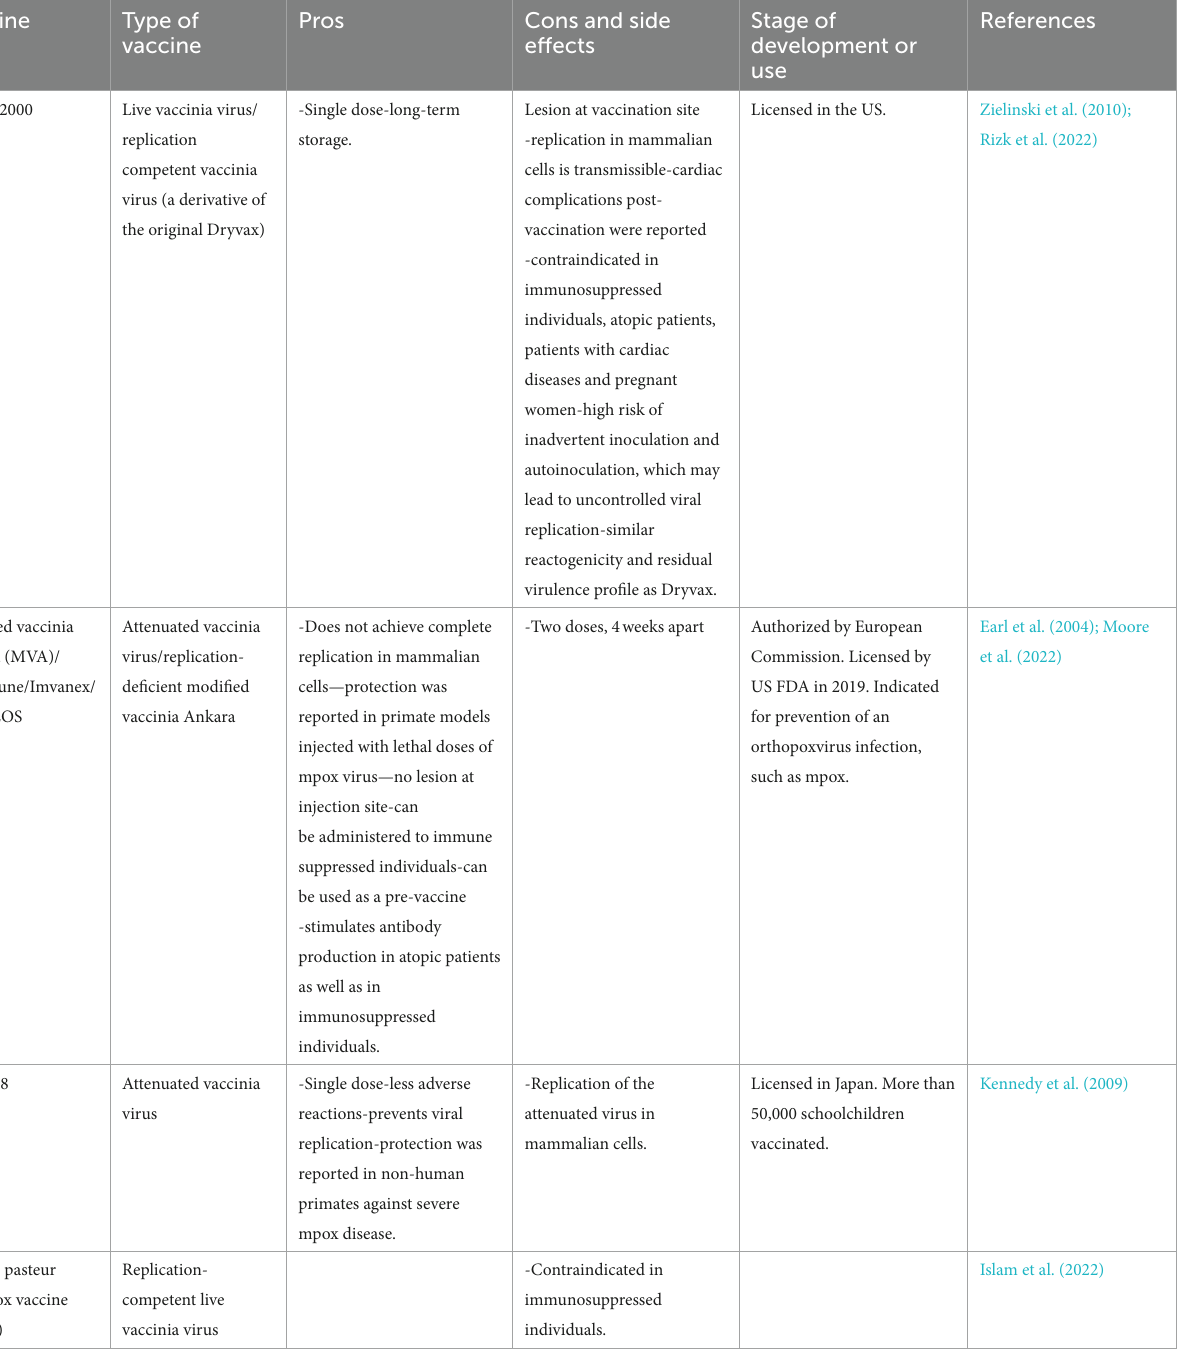
TABLE 1 FDA approved vaccines for the smallpox